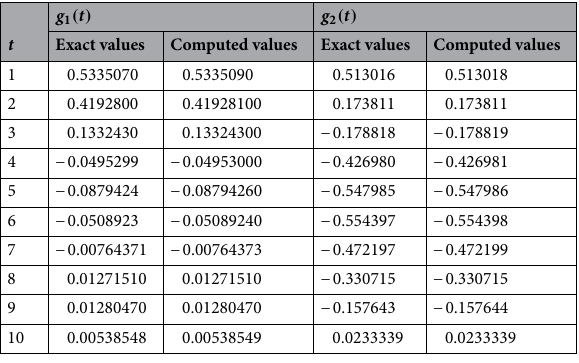
Table 1. Comparison between the numerical inversion and the exact inverse Laplace